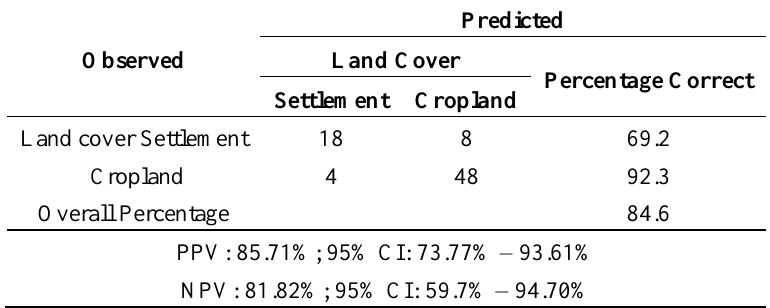
Table A3. Classification table for settlement_2 subgroup model. Classification cutoff value is 0.500. PPV = Positive predicted value and NPV = Negative predicted value.